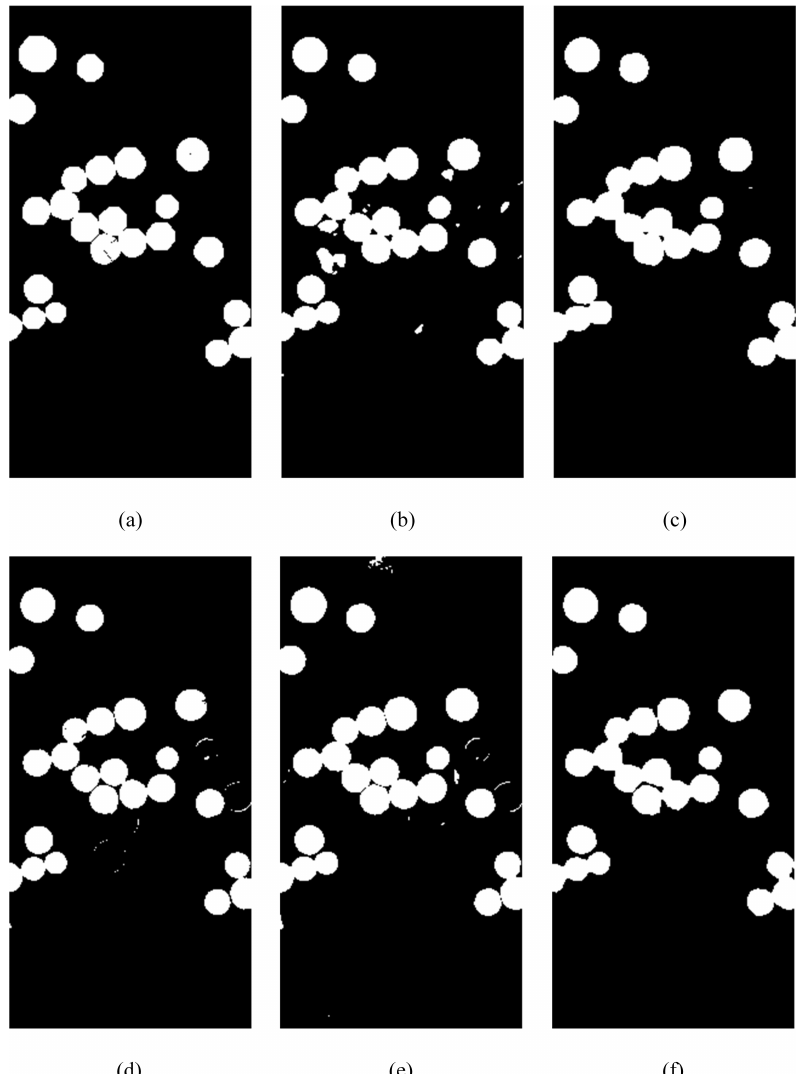
Figure 5. Comparison results of different algorithms on the Hermiston City Area dataset.